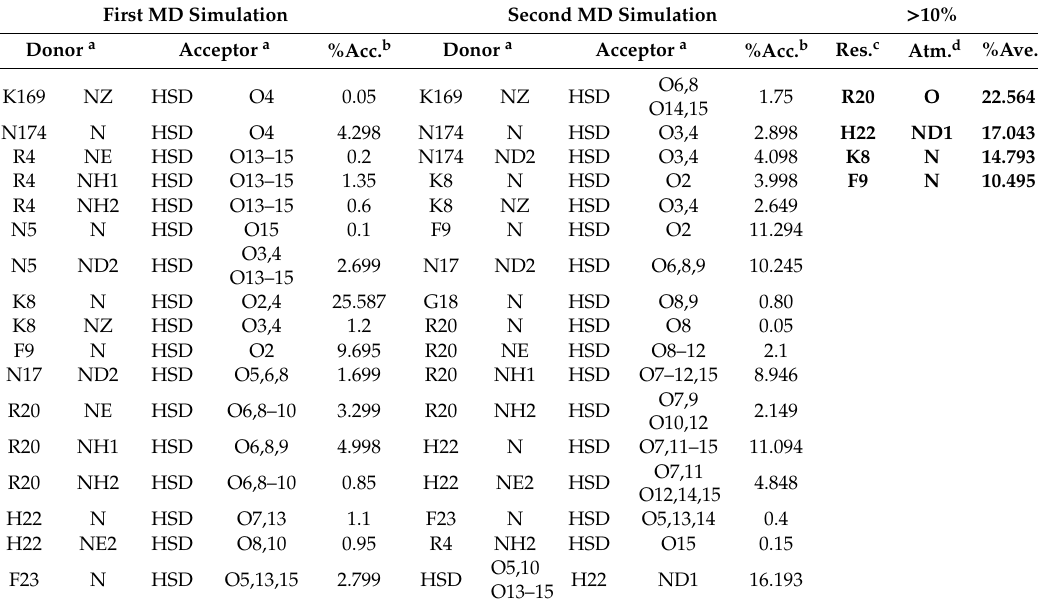
Table 4. The accumulated percentage occupancies (%Acc.) of hydrogen bonds formed between M 2-1 and HSD during 20 ns MD trajectory were obtained for the simulation duplicates. The amino acid residues of the protein involved in hydrogen bonds with average values (%Ave.) of accumulated percentage occupancy higher than 10% (highlighted in bold) were considered as a significant non-covalent interaction for the molecular stabilization of the M 2-1 / HSD